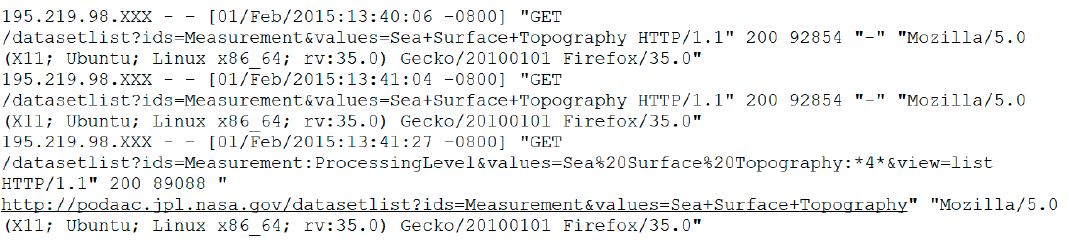
Figure 2. Sample Physical Oceanography Distributed Active Archive Center (PO.DAAC) HTTP logs in Combined Log Format.